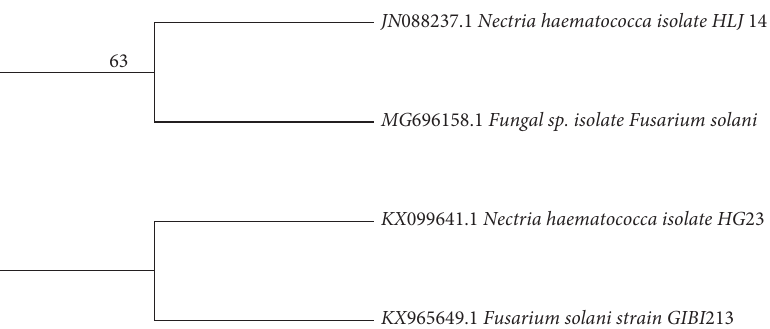
Figure 5: Phylogenetic tree from the sequence of the pathogen isolated from soursop.